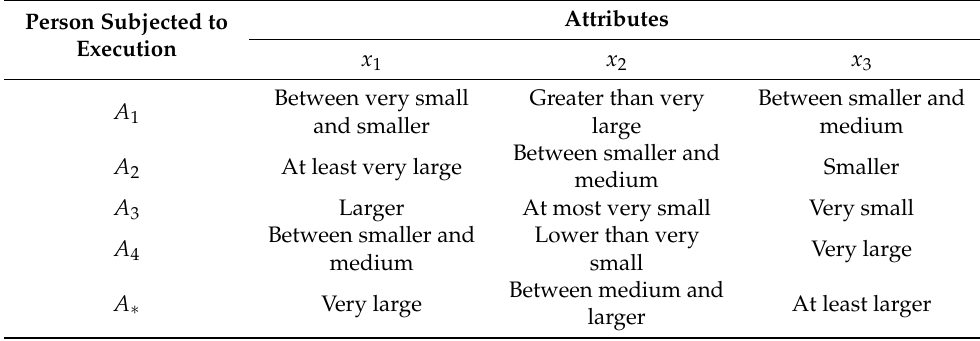
Table 1. The evaluation results given by the executive judge in linguistic expressions.